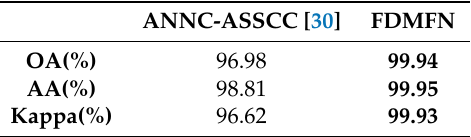
Table 15. Comparison between the proposed FDMFN and the artificial neuron network with center-loss and adaptive spatial-spectral center classifier (ANNC-ASSCC) [30] on the Salinas dataset. Note that the best results reported in [30] were used for comparison here. In addition, the best results are highlighted in bold